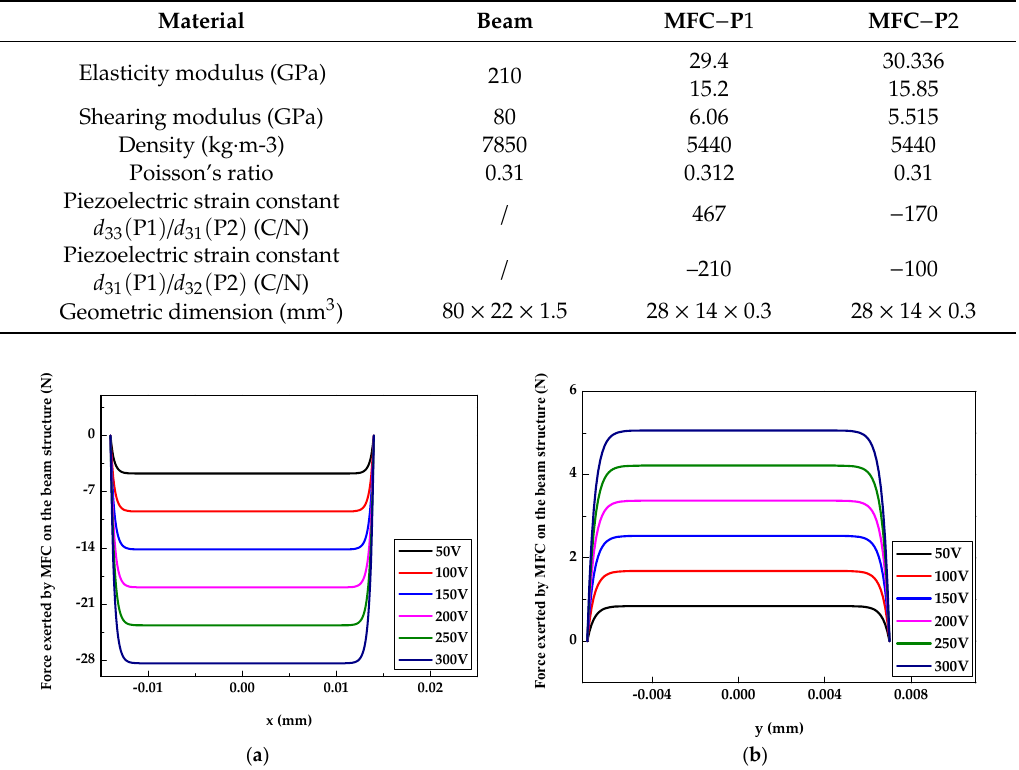
Figure 7. The mean internal force distribution of the M2814-P1 type of MFC under different voltages. ( a ) The direction of the x axis; ( b ) the direction of the y axis.